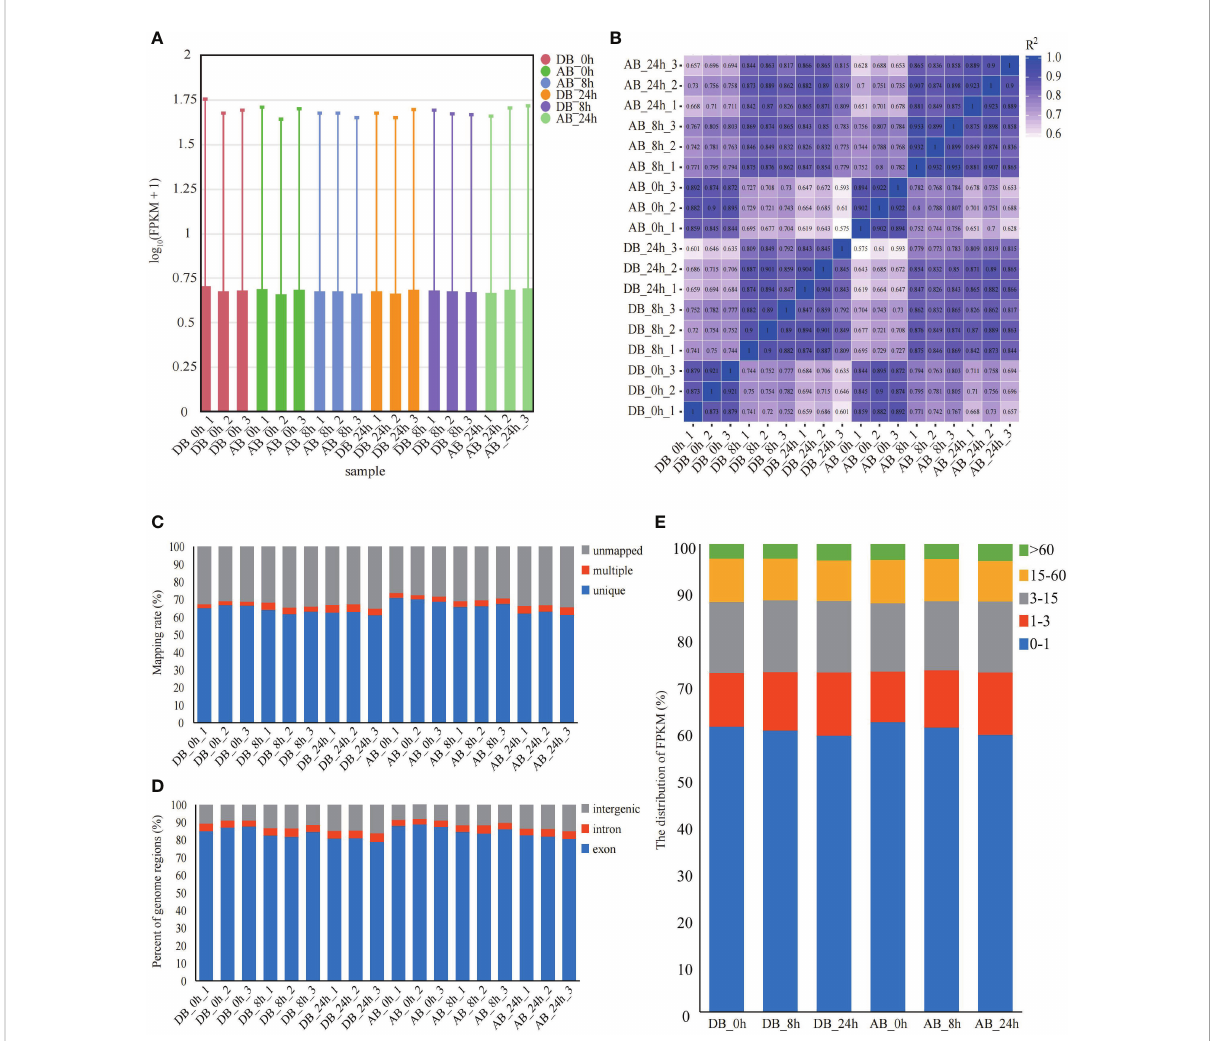
FIGURE 2 Mapping results of Dianbei and Anba. (A) The FPKM of Dianbei and Anba. The abscissa in the graph indicates different samples; the ordinate indicates the logarithmic values of the sample expression FPKM. (B) Pearson correlation between Dianbei and Anba. (C-E) Mapping ratio (C) , percent of genome regions (D) , and distribution of FPKM (E) in the roots of Dianbei and Anba under submergence